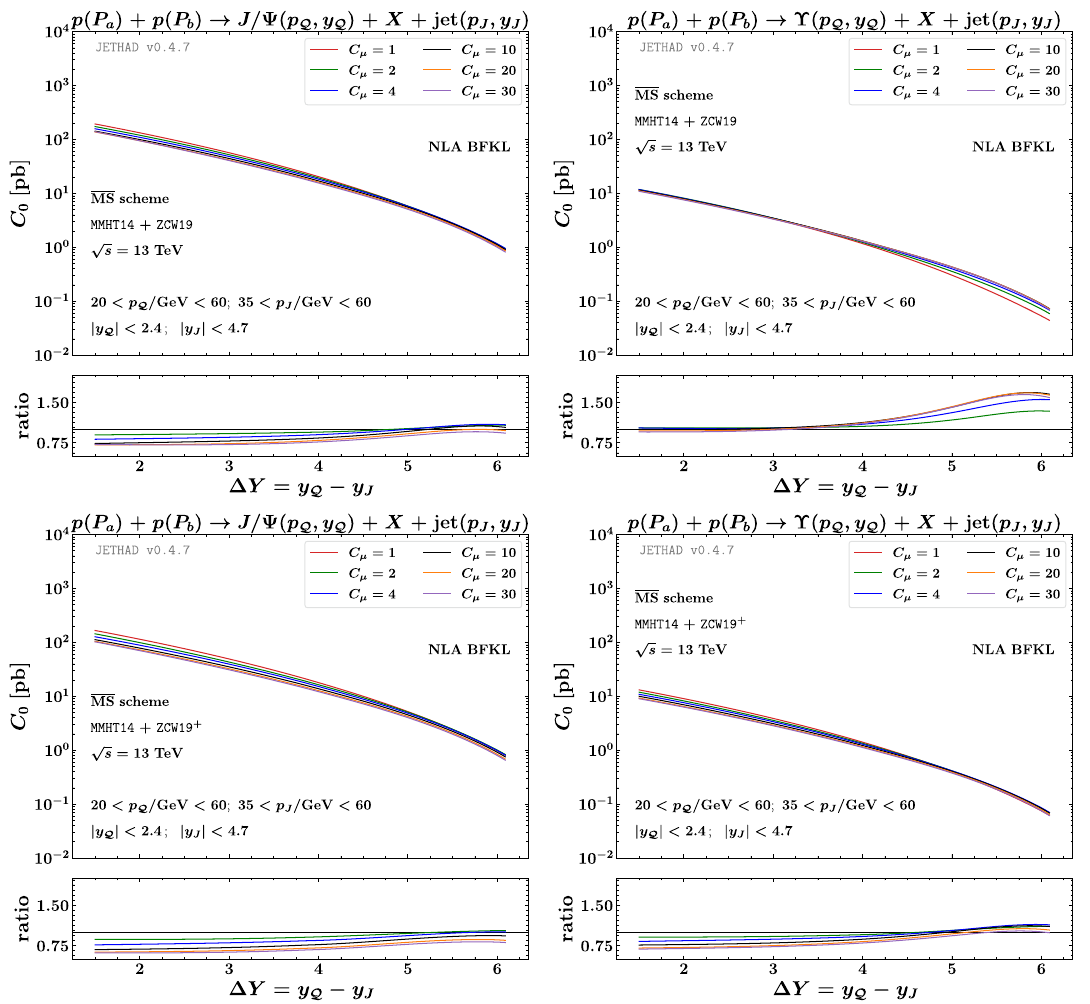
Fig. 5 (cid:9) Y -distributioninthe J /ψ + jet(left)andinthe ϒ + jet(right) √ s = 13 TeV. Quarkonium fragmentation is described channel, for in terms of ZCW19 (upper) or ZCW19 + (lower) functions. A study